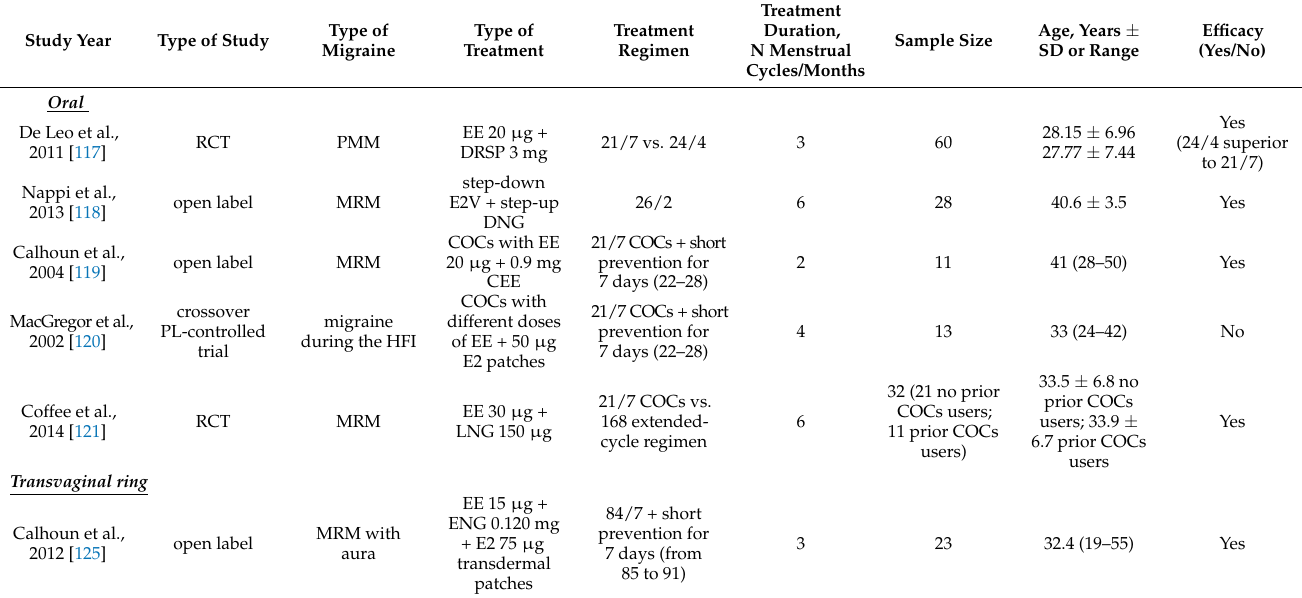
Table 1. Main characteristics of the studies on Combined Hormonal Contraception (CHC) in the treatment of